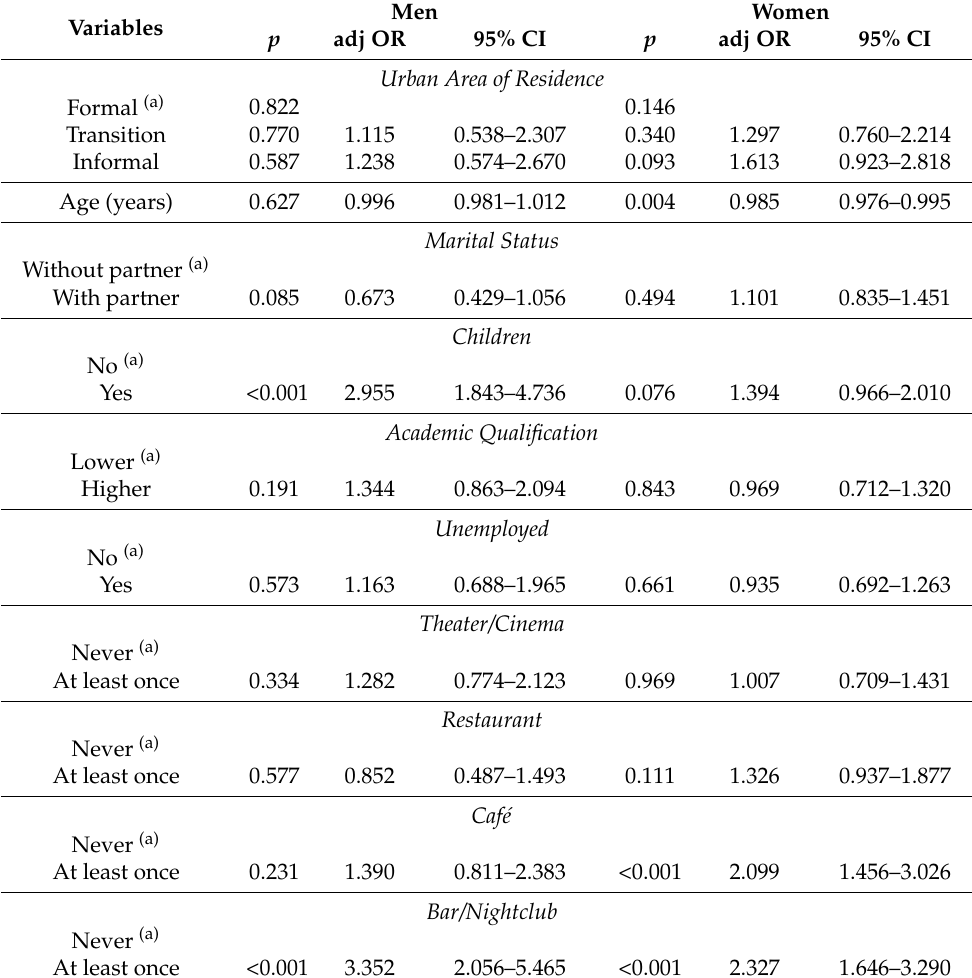
Table 3. Multiple logistic regression models for consumption of alcoholic beverages by